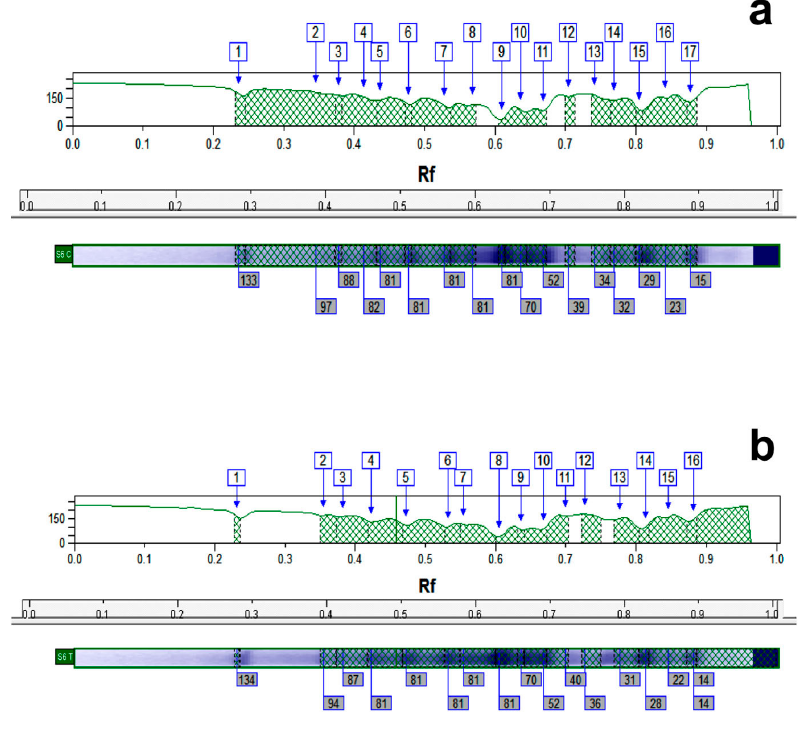
Fig. 4 . Representative dendogram viewing the protein pattern for S6 MRSA isolate control (a) and treated (b) sample with 16µg/ml of caspofungin used for the computerized detection of the occurrence of monomorphic